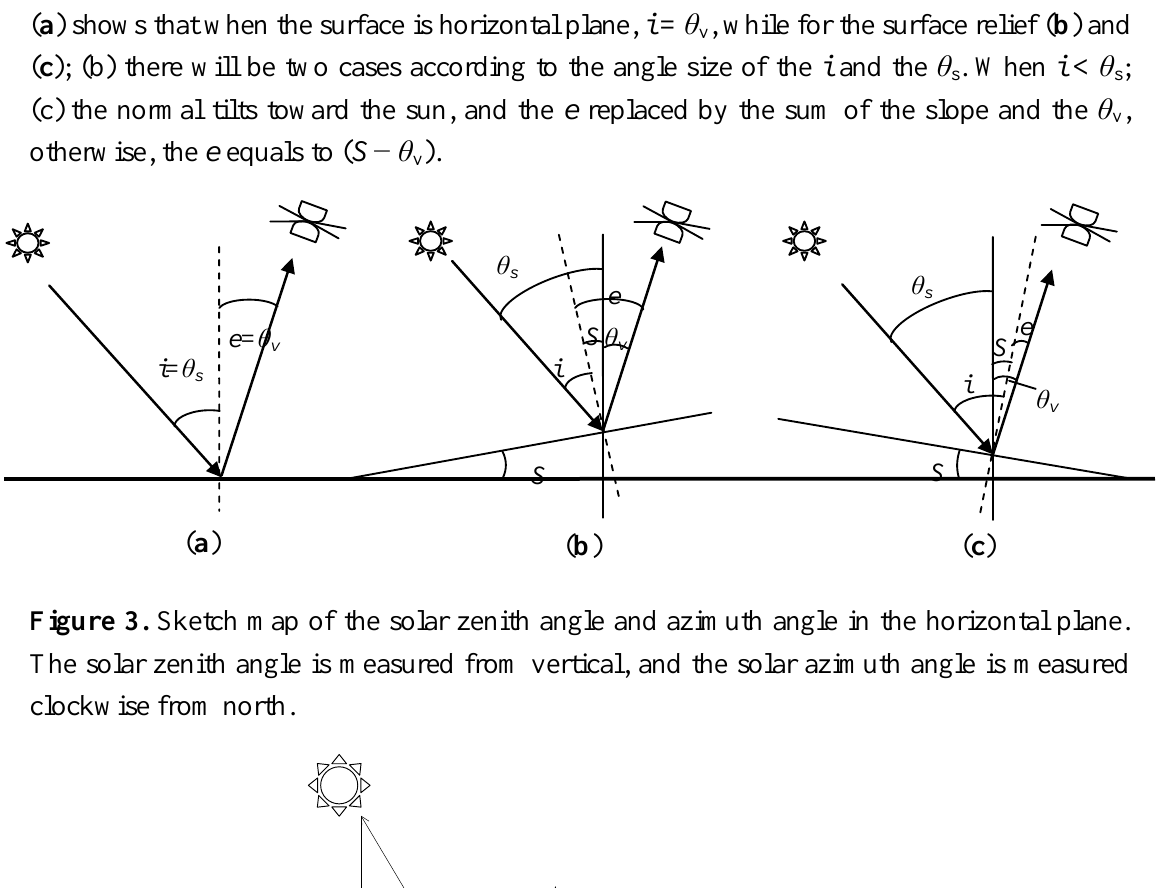
Figure 2. The geometric relationship of the possible solar-ground-sensor constellations. ( a ) shows that when the surface is horizontal plane, i = θ